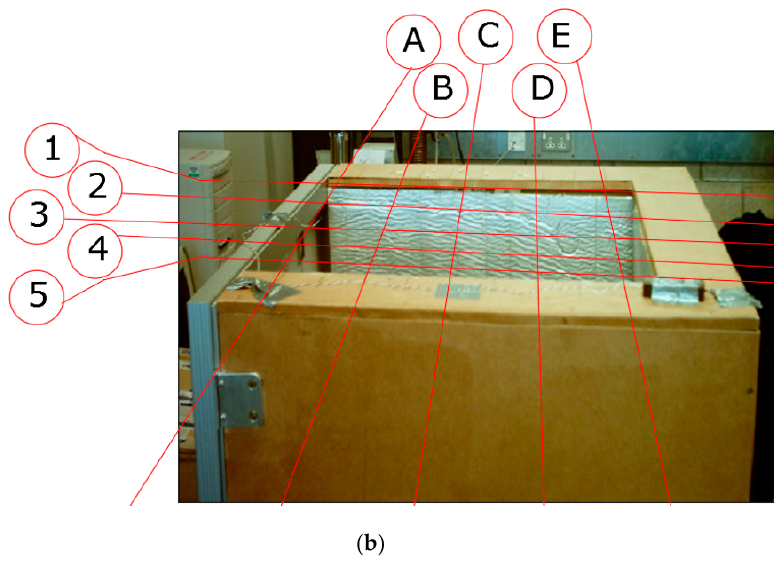
Figure 2. ( a ) Schematic of the experimental setting and sequence of duct positions. ( b ) Locations of hot wire anemometer air velocity measurements ducts of 30–50 cm width.